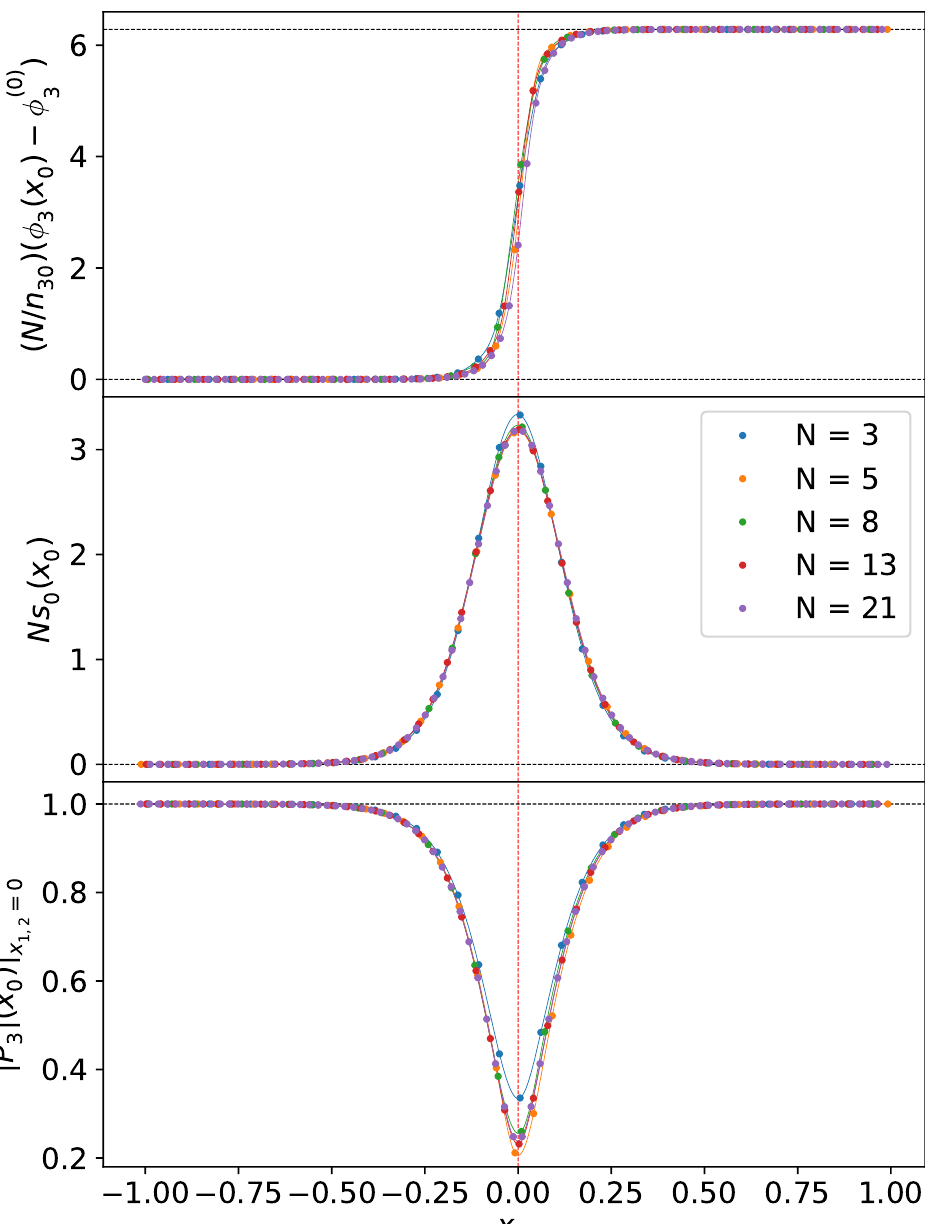
Figure 10. For a torus of size l 0 = 2 l 3 = 2 l , we display as a function of time and from top to bottom: the phase of the Polyakov loop P multiplied by N/n (after subtracting the required powers of 3 30 2 π/N so as to have the phase at x = − l 2 close to zero), the energy-profile of the instanton, and 0 0 / the modulus of P . The phase and modulus of the Polyakov loop are evaluated at: x 3